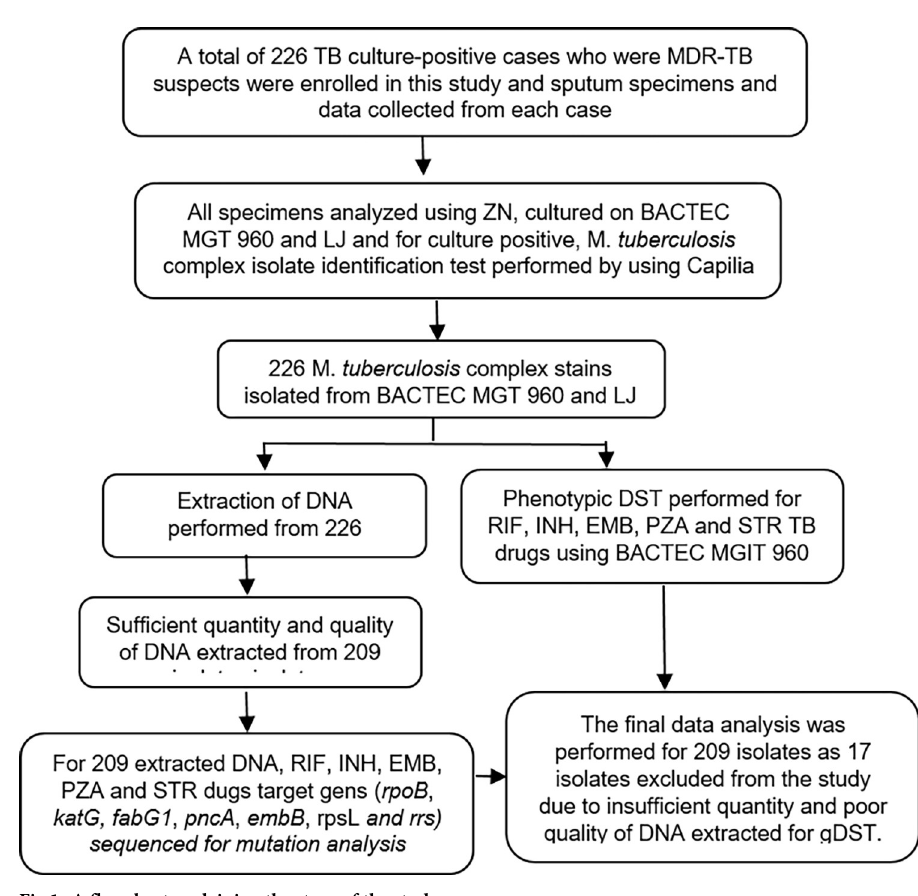
Fig 1. A flowchart explaining the steps of the